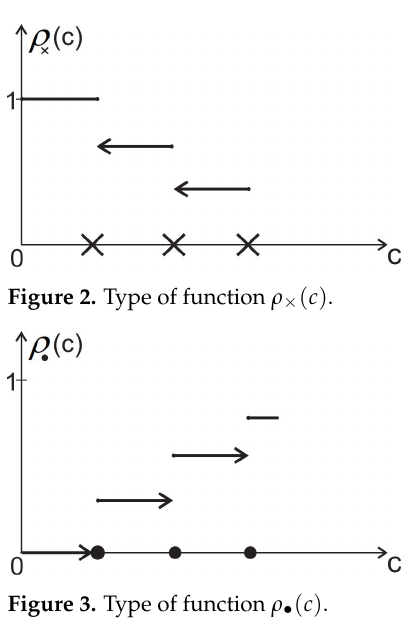
Figure 3. Type of function ρ • ( c )